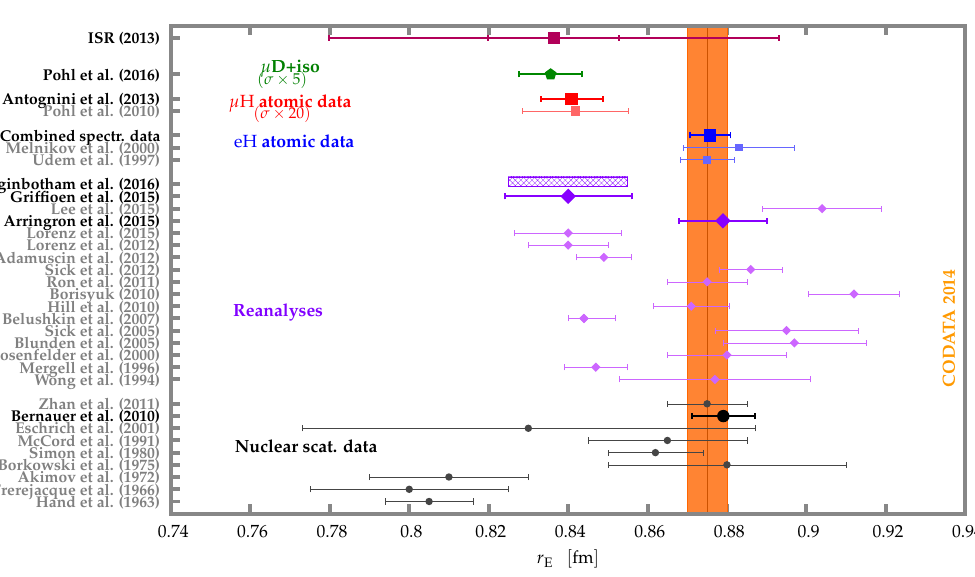
Figure 1. An overview of the available proton charge radius measurements. Full circles show findings of the scattering experiments. Full squares represent values obtained from the Lamb shift spectroscopy. The values determined from the muonic hydrogen (deuterium) measurements are colored red (green). The uncertainties of muonic hydrogen (deuterium) data are multiplied by factor 20 (5) for clarity [6]. The value extracted from the ISR experiment is shown with the purple square at the top of the plot